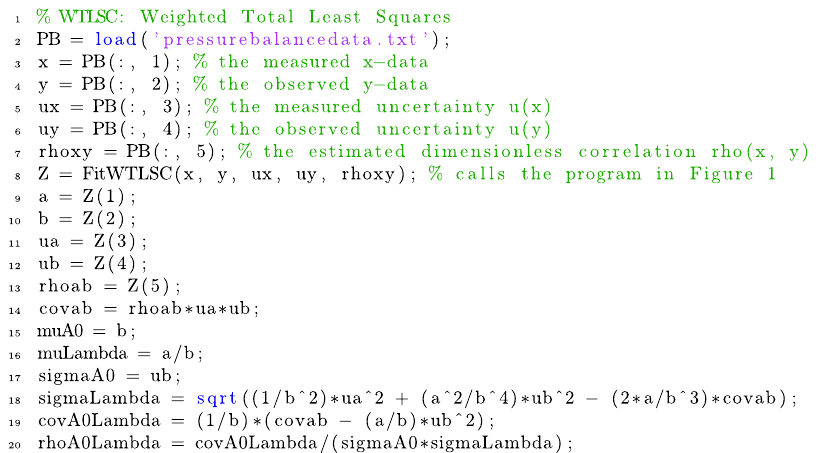
Fig. 2. Gnu Octave/Matlab script fi le using the function fi le FitWTLSC.m to calculate the pressure balance parameter values and associated variance and covariance information in a typical pressure laboratory calibration certi fi cate for a client pressure balance instrument. The data in the loaded fi le is from Table 1 and may conveniently be extracted from an Excel spreadsheet of measurement results and as saved a txt fi le.